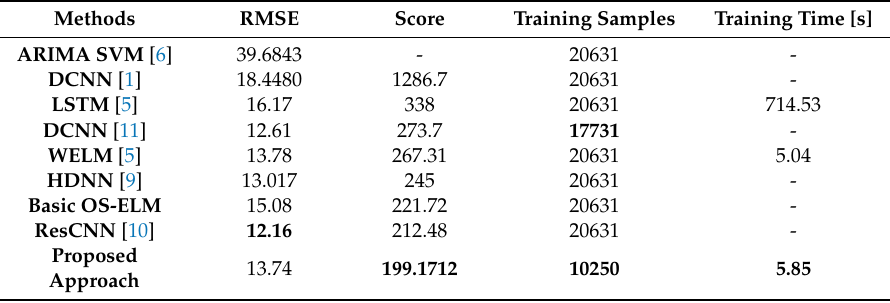
Table 2. Performance results compared to other recent RUL prediction approaches.